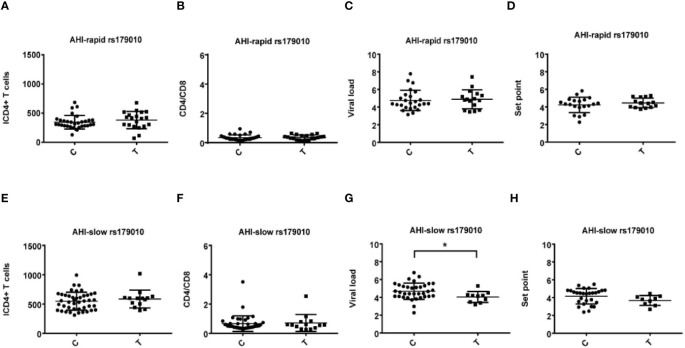
Relationship between rs179010C/T and clinical parameters in AHI patients with rapid/slow progress. (A–H) There are four clinical parameters including, ICD4 (initial CD4 T cells) (A, E), CD4/CD8 (the ratio of CD4 versus CD8 T cells) (B, F), viral load (C, G), and set point (D, H). The y axis indicates the values of these four respective parameters. The x axis, indicates two patient groups with TLR7 rs179010C/T allele. The text on the top of each picture represents AHI-rapid/slow patients. Each dot represents an MSM individual, (●) represents individuals of AHI-rapid/slow progress with TLR7 rs179010C allele. (■) represents individuals of AHI-rapid/slow progress with TLR7 rs179010T allele. *indicates P < 0.05; P < 0.01 and P < 0.001.